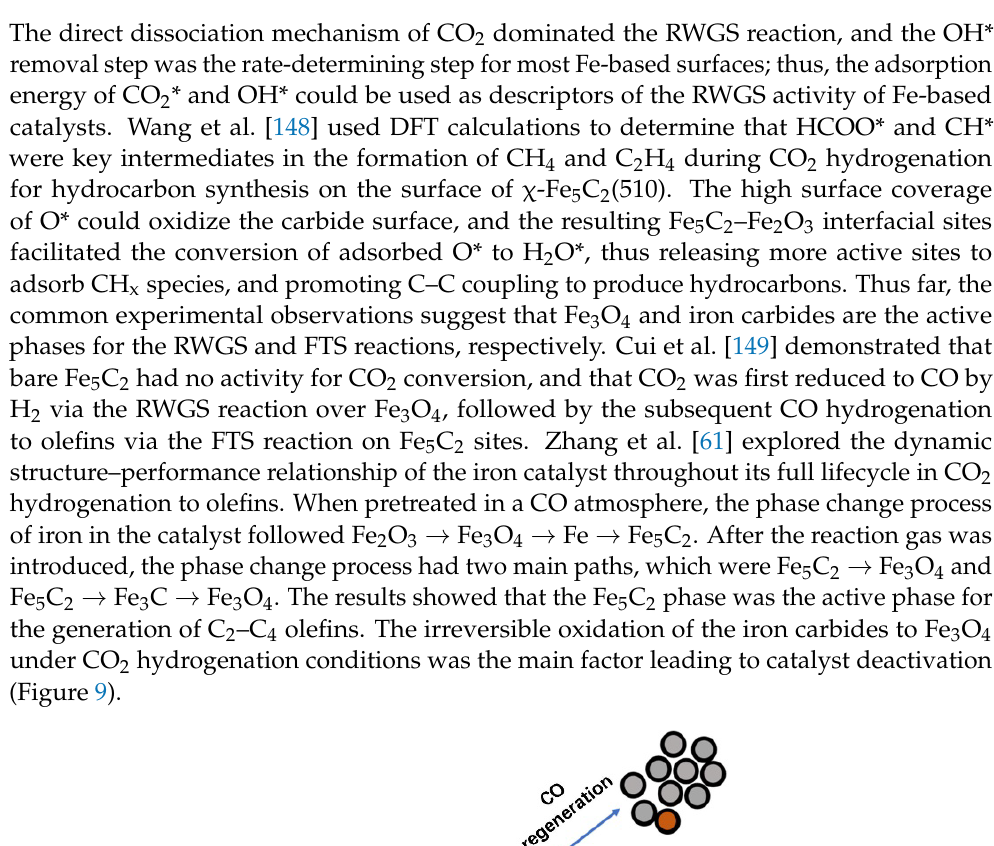
Figure 10. Qualitative interpretation of the ab initio atomistic thermodynamics study of iron car- bides structures (gray arrows indicate transformations where entropic contributions to the total free energy may be significant. The dashed arrow indicates that the transformation may be kinetically inhibited). Reprinted with permission from ref. [152] . Copyright 2010 American Chemical Society.